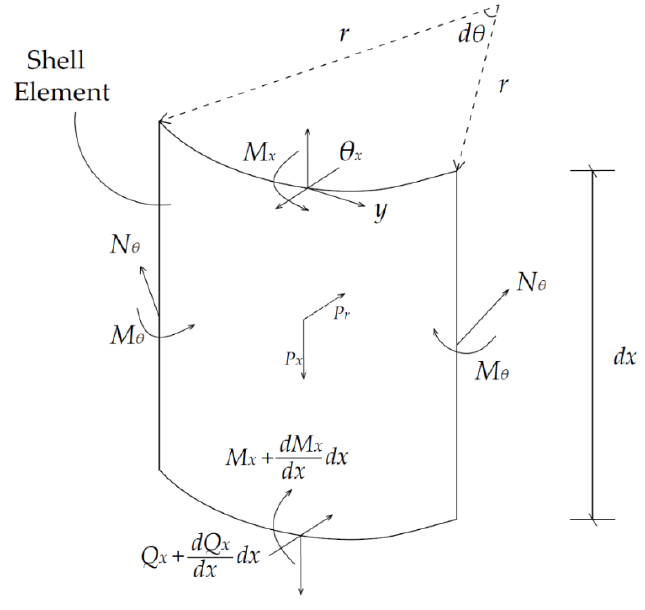
Figure 3. Loads on a shell element.